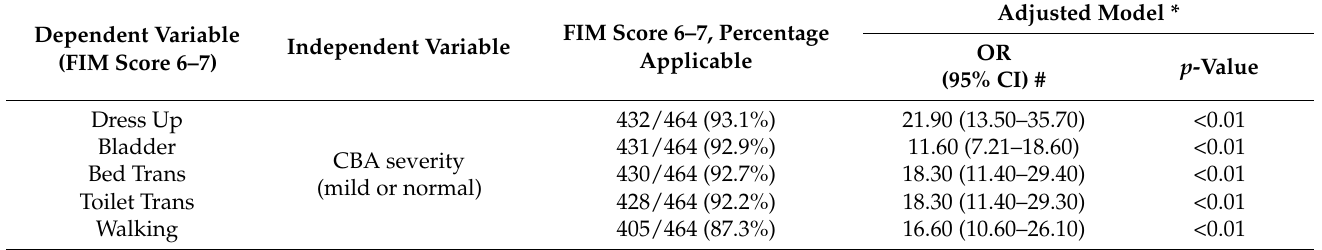
Table 4. Association of mild or normal level based on the CBA with independence in walking and independence in ADL items affecting discharge to